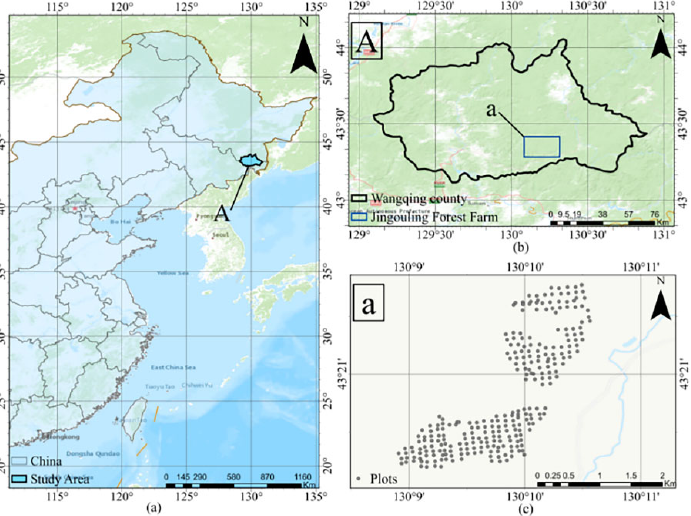
Figure 1. Location of the study area and spatial distribution of sample plots. ( a ): the study area in Wangqing county, ( b ): Jingouling Forest Farm, ( c ): plots.